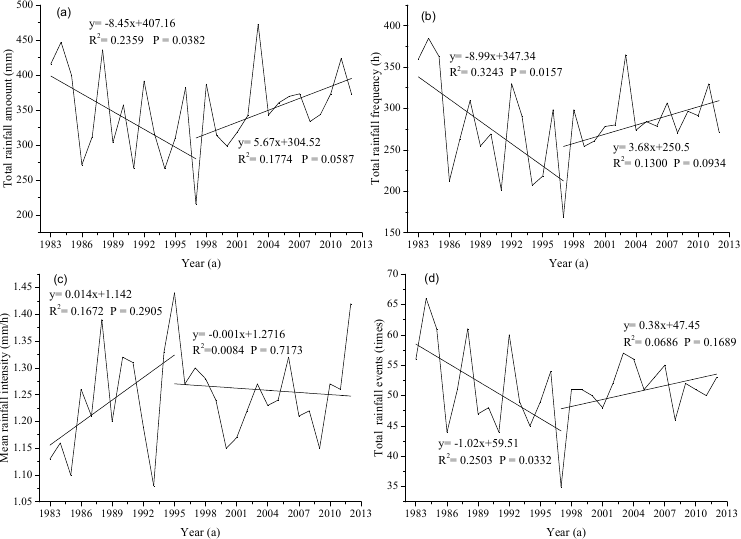
Figure 2. Interannual changes in regional mean ( a ) ATR (annual total rainfall amount), ( b ) ARF (annual total rainfall frequency), ( c ) ARI (annual mean rainfall intensity) and ( d ) ATE (annual total rainfall events) during the RS (rainy season) from 1983 to 2012.